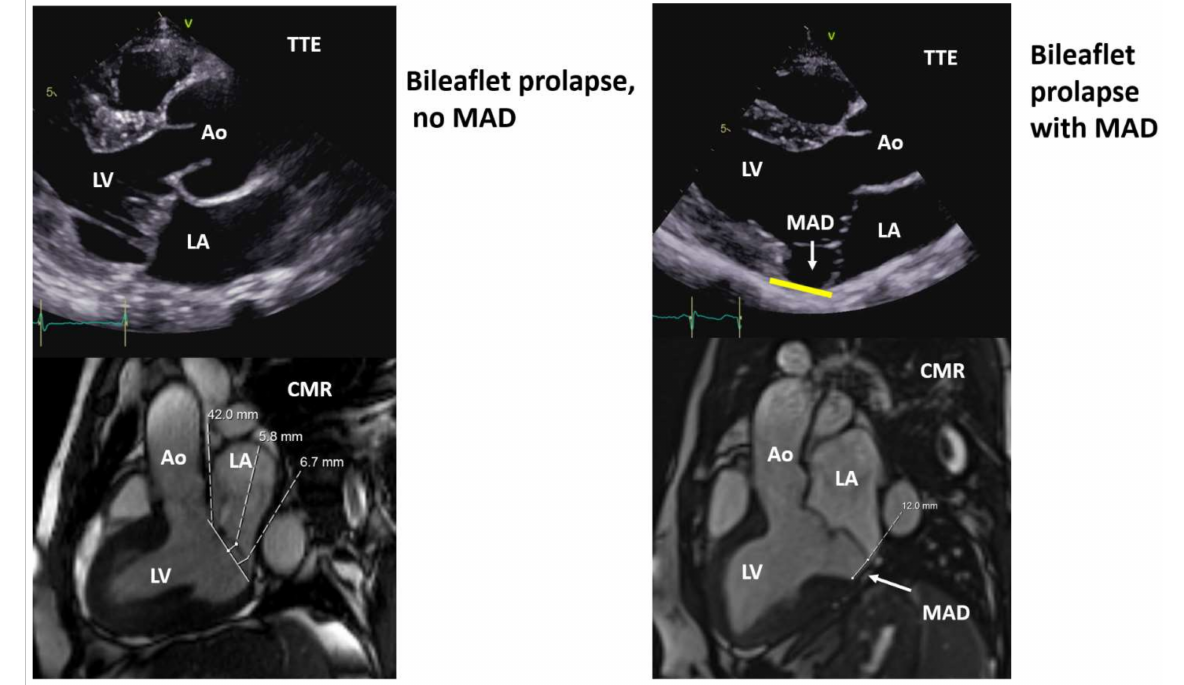
Figure 4. Mitral valve prolapse with no mitral annulus disjunction (MAD) and with MAD (upper panels: TTE, lower panels CMR). Ao, aorta; CMR, cardiac magnetic resonance; LA, left atrium; LV, left ventricle; TTE, transthoracic echocardiography.